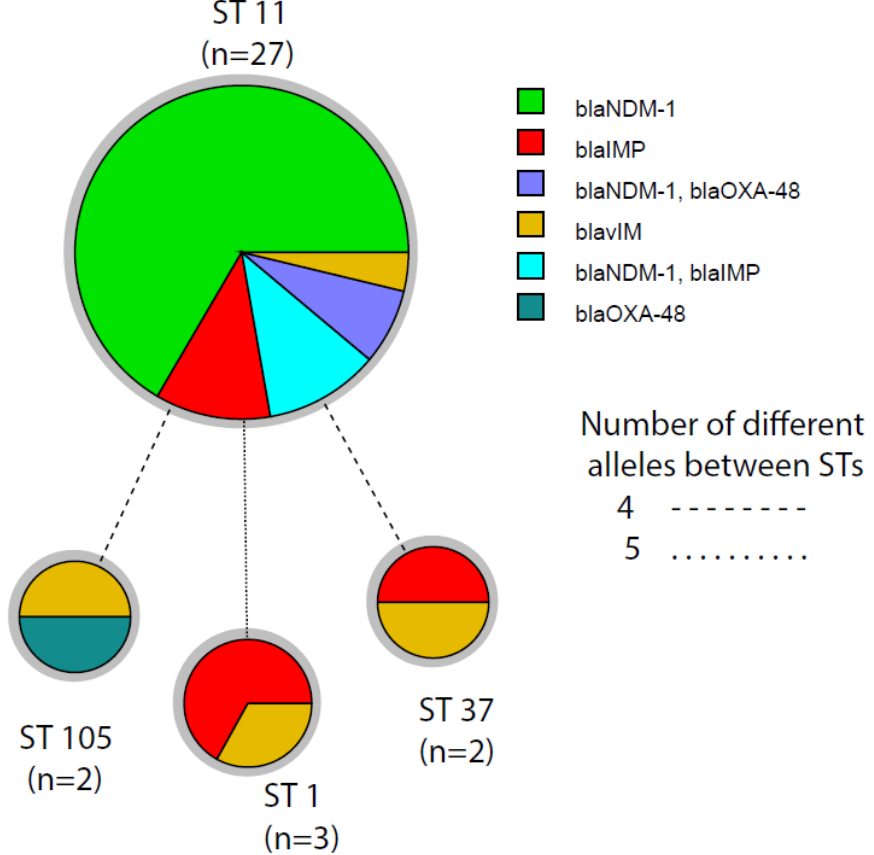
Figure 2. Minimum spinning tree of carbapenemases-producing K. pneumoniae isolates based on the MLST alleles and sequence type (ST). The nodes represent the STs, sizes of nodes characterize the number of isolates, and length of branches shows the number of different alleles out of seven MLST alleles. Nodes are labeled with the corresponding sequence type.